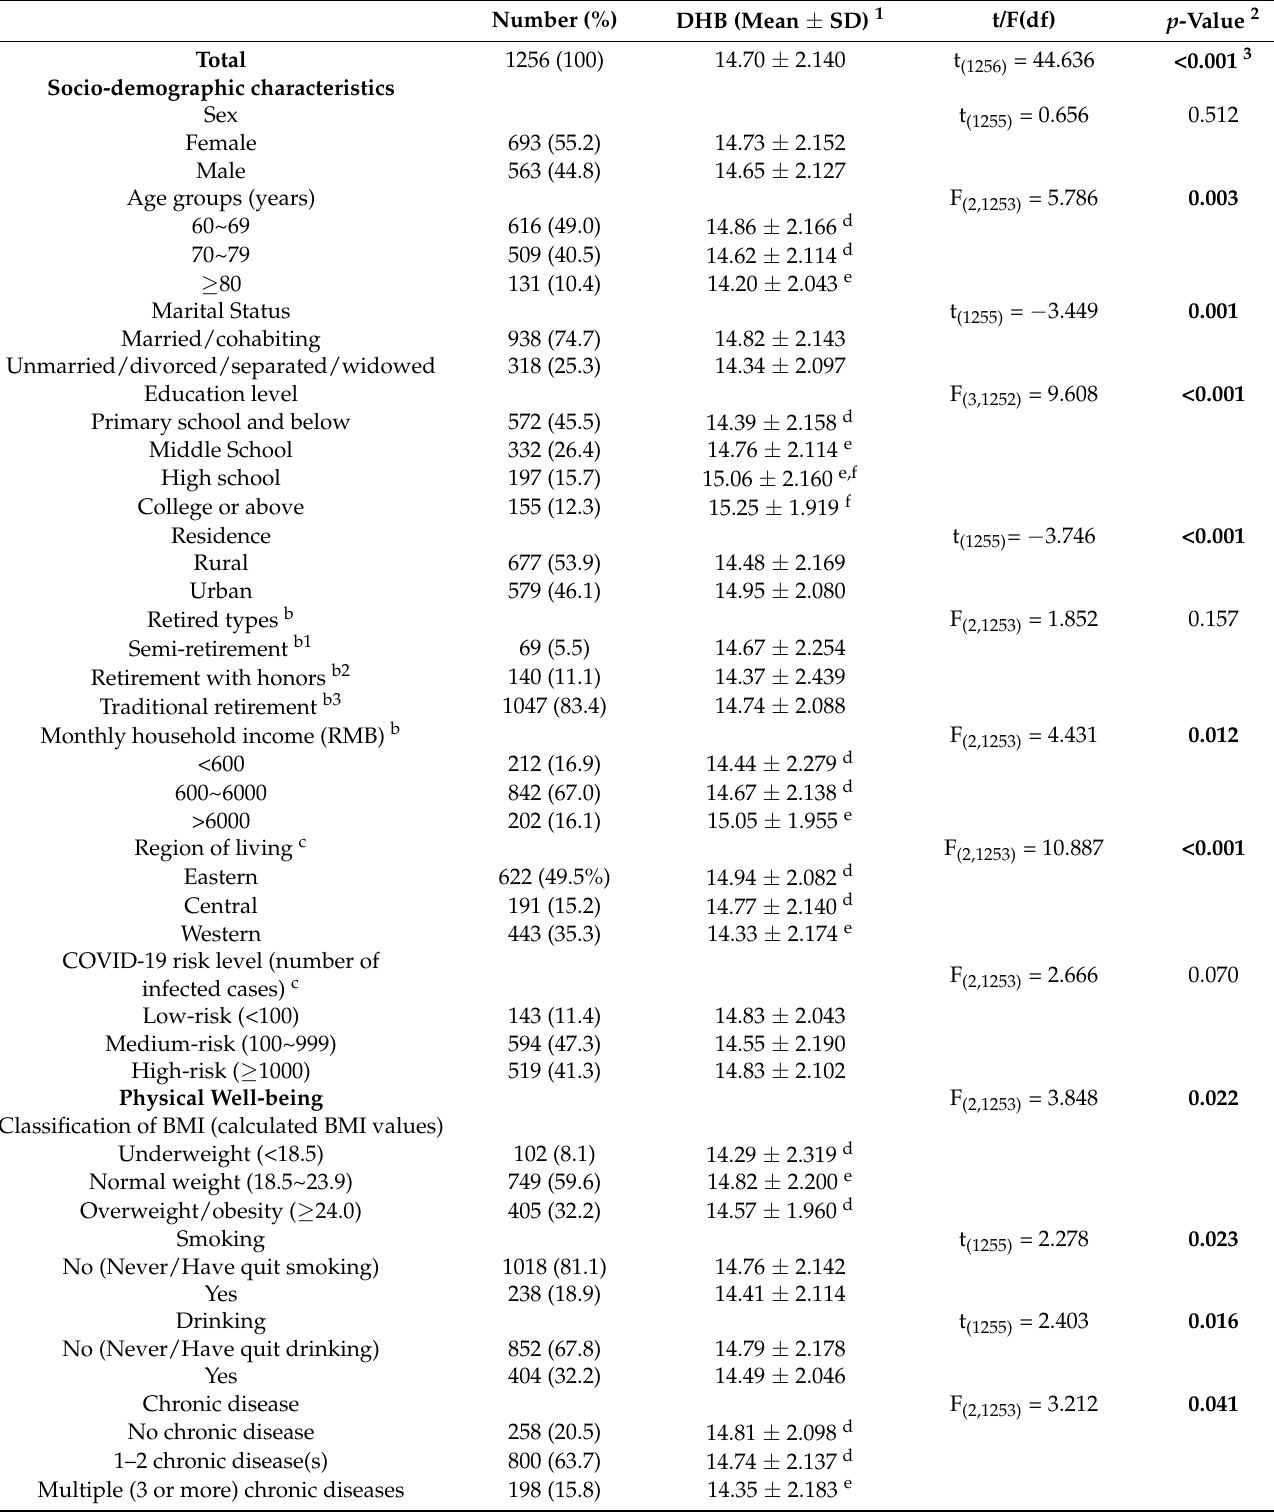
Table 1. Univariate analysis of participants’ general information ( socio-demographic characteristics , physical well-being , and self-assessment of health ) on their DHB performance during the COVID-19 pandemic ( n = 1256) a